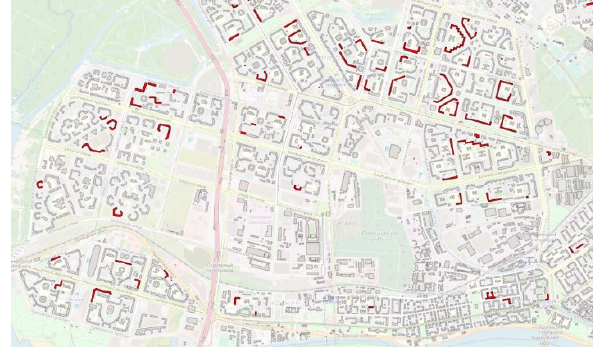
Figure 8. Visualization of HIV cases reported in 2010 in Primorsky district of St. Petersburg (base map © OpenStreetMap contributors)